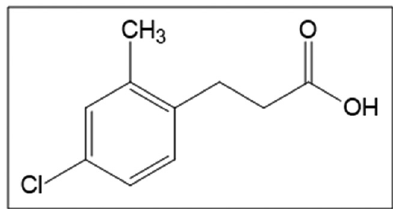
Figure 1: Chemical structure of